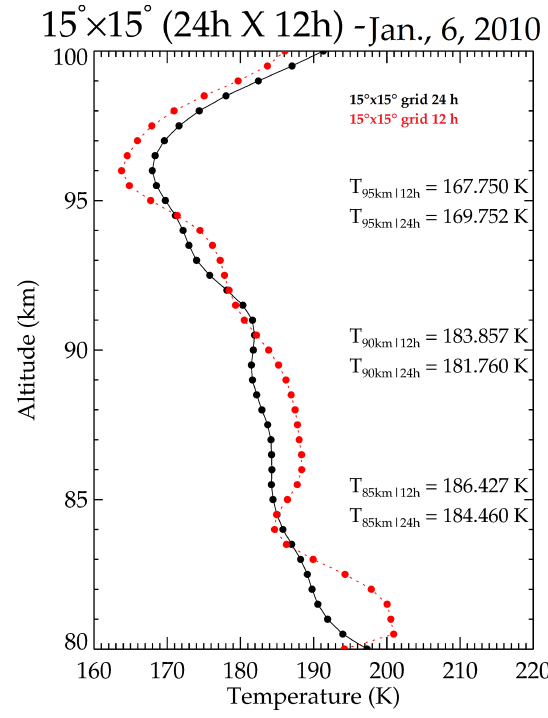
Figure 4. Temperature profiles of the MLT region as retrieved from SABER/TIMED observations over Santa Maria, southern Brazil, on 6 January 2010, but comparing a 24 and a 12h analysis in the 15 ◦ × 15 ◦ grid. The 24h analysis is shown in black; note that this is the same profile shown in Fig. 3. In red, the 12h analysis is